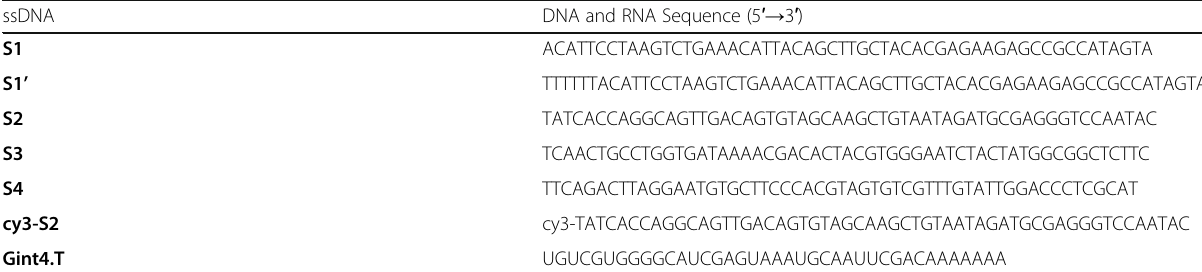
Table 1 Sequence of each single-strand DNA and RNA ssDNA DNA and RNA Sequence (5 ′ → 3 ′